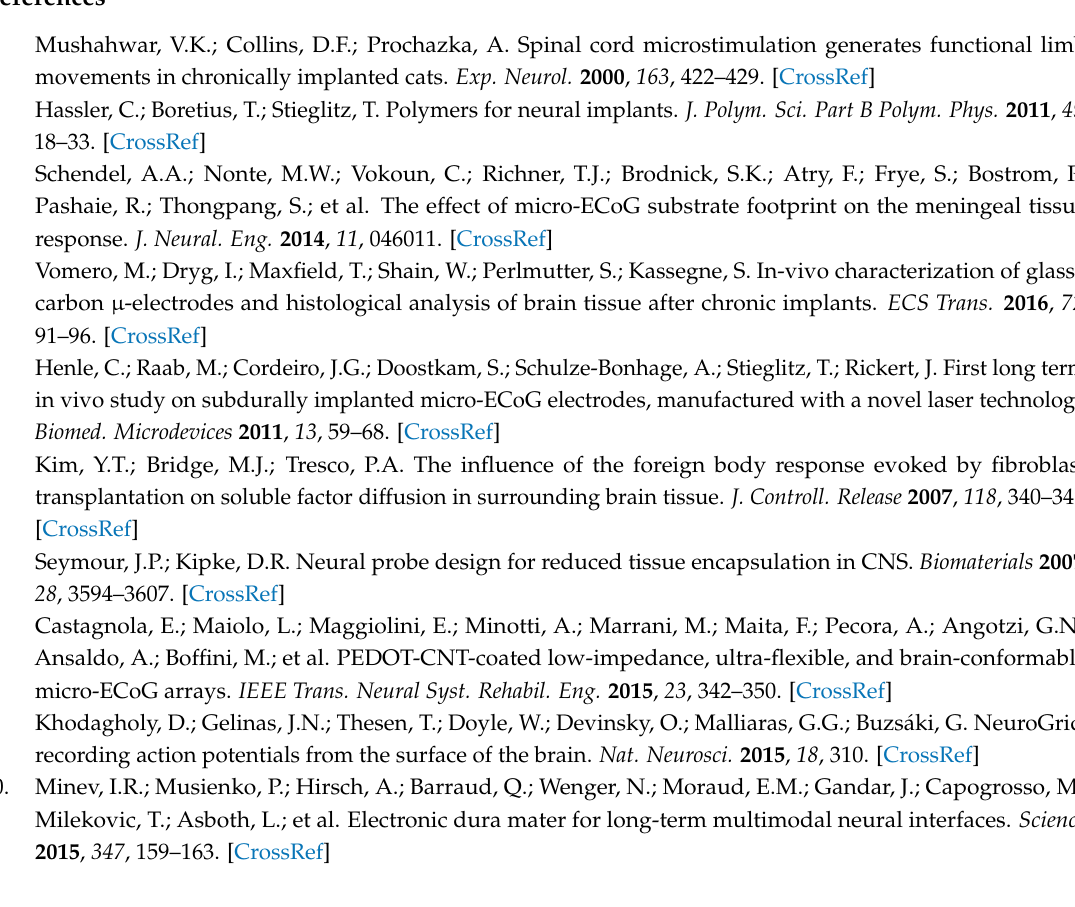
s1, Table S1: Geometrical values for disk-shaped glassy carbon structures. All samples had a height of 13 µ m before pyrolysis; Table S2: Values of impedance at 1 kHz and charge density before and after stimulation. N = 3; Table S3: Relative quantities (%) of different compounds for various diameter pyrolyzed carbon electrodes; Table S4: Observed amplitude range of the background noise for every electrode diameter before and after PEDOT:PSS deposition; Video S1: Glassy Carbon ECoG Electrodes on Ultra-Conformable and Finger-Like Polyimide Substrate on Rat